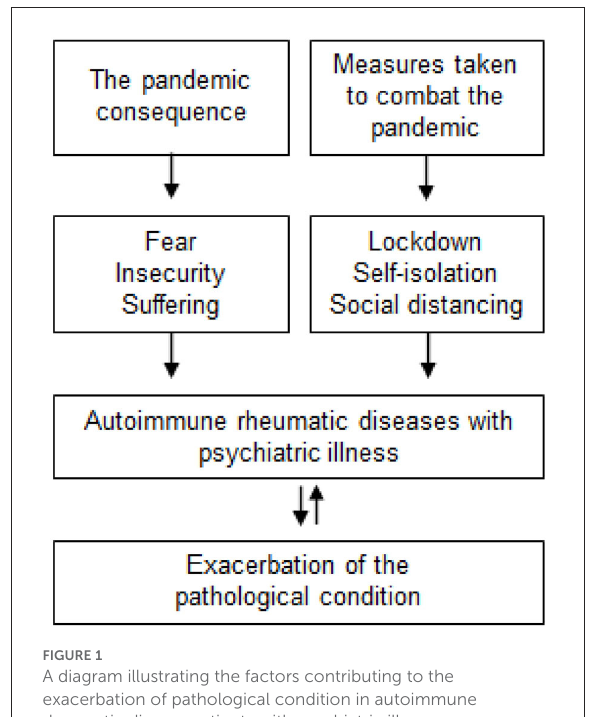
FIGURE1 A diagram illustrating the factors contributing to the exacerbation of pathological condition in autoimmune rheumatic disease patients with psychiatric